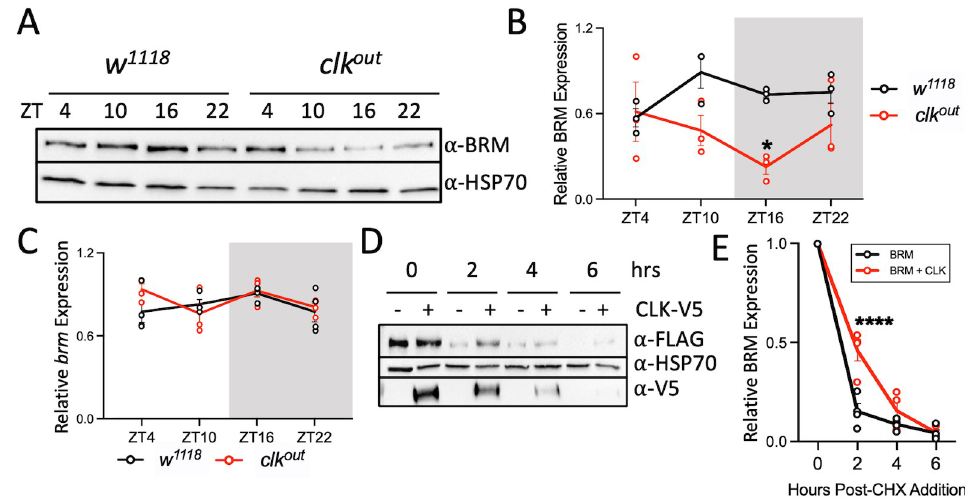
Fig 3. CLK stabilizes BRM protein. (A-B) BRM protein and (C) brm mRNA levels in the heads of w 1118 (black) and clk out (red) flies collected at the indicated time points on LD3. (B) BRM signal (A: top panel) was quantified and normalized to HSP70 (A: bottom panel) (n = 3). The grey background denotes the dark phase of the LD cycle. Each data point represents a biological replicate. Error bars represent ± SEM. Asterisks denote significant p-values: � p < 0.05. (C) Steady state brm mRNA was normalized to cbp20 mRNA expression. Each biological replicate (n = 4) is an average of 2 technical replicates of qPCR. (D) Western blot detecting FLAG-tagged BRM (top panel) every 2 hours (hrs) post- cycloheximide (CHX) addition to S2 cells expressing brm alone or brm co-expressed with clk . HSP70 was used as a loading control (middle panel). V5 was detected to confirm CLK-V5 expression (bottom panel). (E) BRM expression was normalized to HSP70 (n = 3). Asterisks denote significant p-values: ���� p <